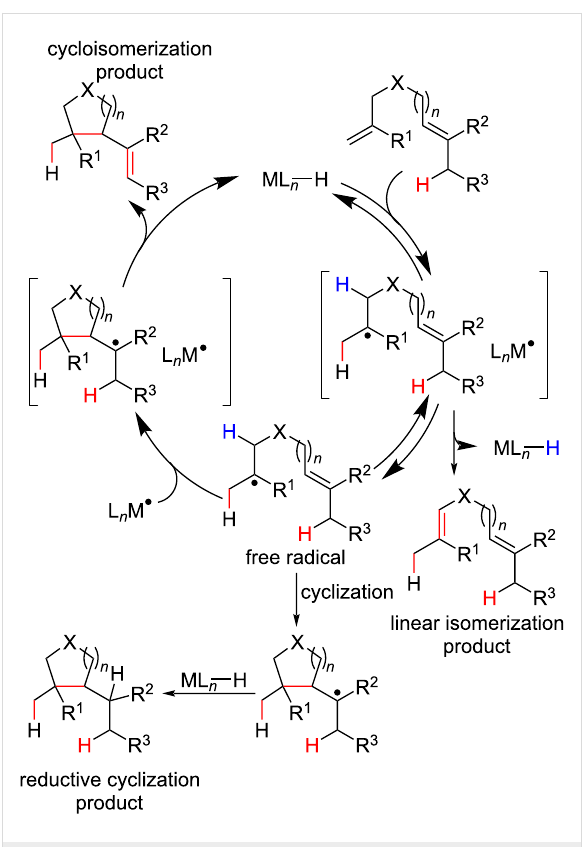
reactions and allowing benzylic radical dimerization to